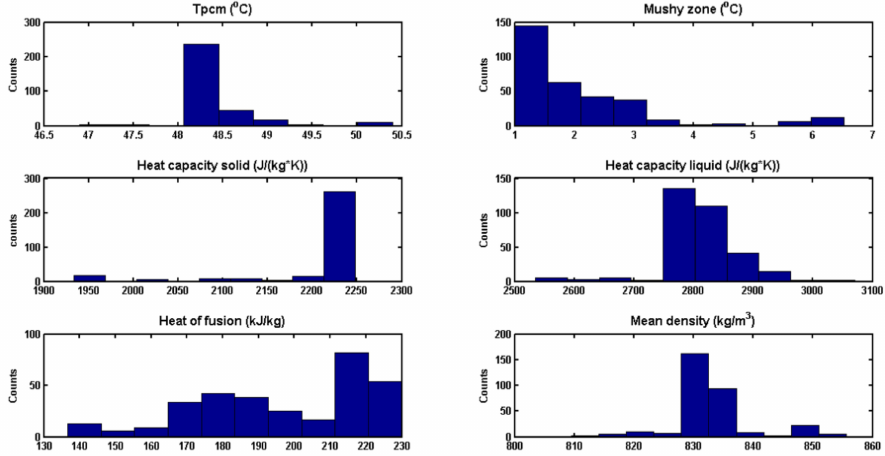
Figure 7. Statistical distribution of PCM intrinsic properties during the optimization process.